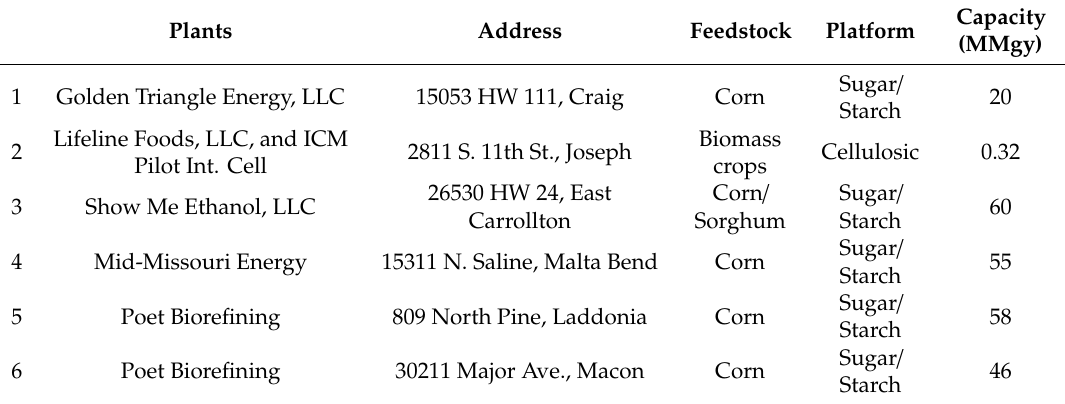
Table 1. Details of Missouri operating biorefineries in the study area including necessary location information as well as current feedstock information and capacity.